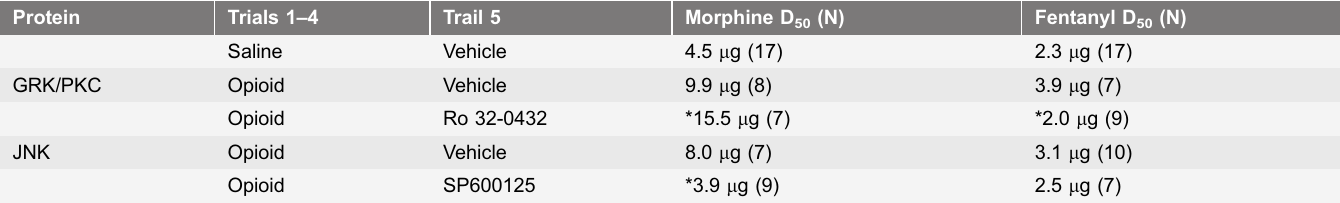
Table 1. Effect of GRK/PKC and JNK inhibition on the Expression of Tolerance. Protein